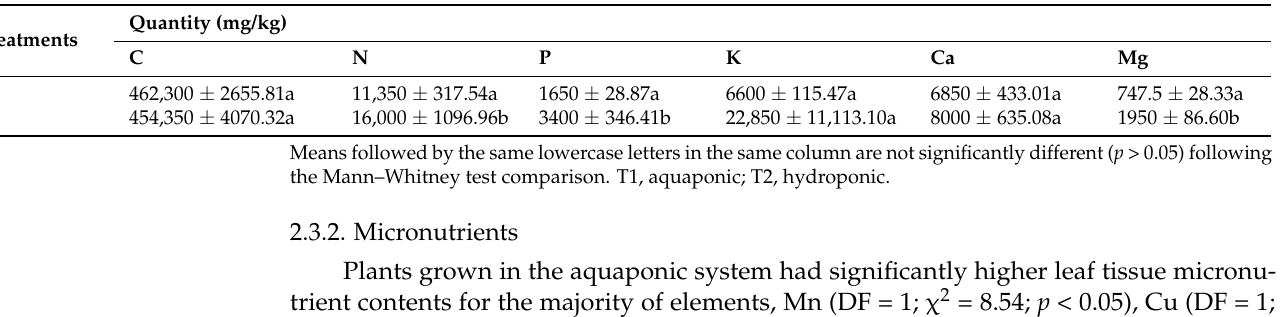
Table 2. Tissue nutrient contents of shoots (mean ± SE) of H. odoratissimum grown in aquaponic and hydroponic systems for six weeks under greenhouse conditions.